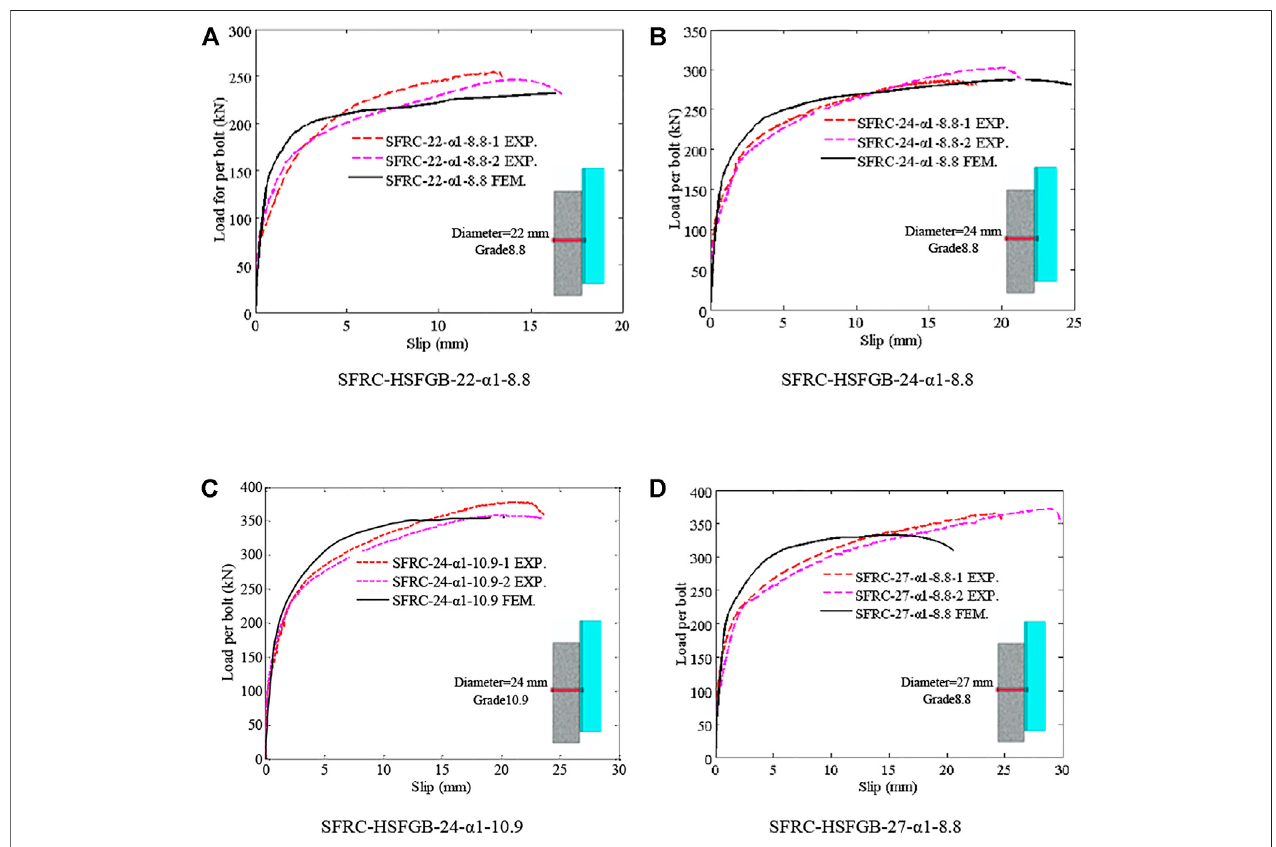
FIGURE 6 | Comparison of the numerical and tested results obtained for load-relative slip relationship.